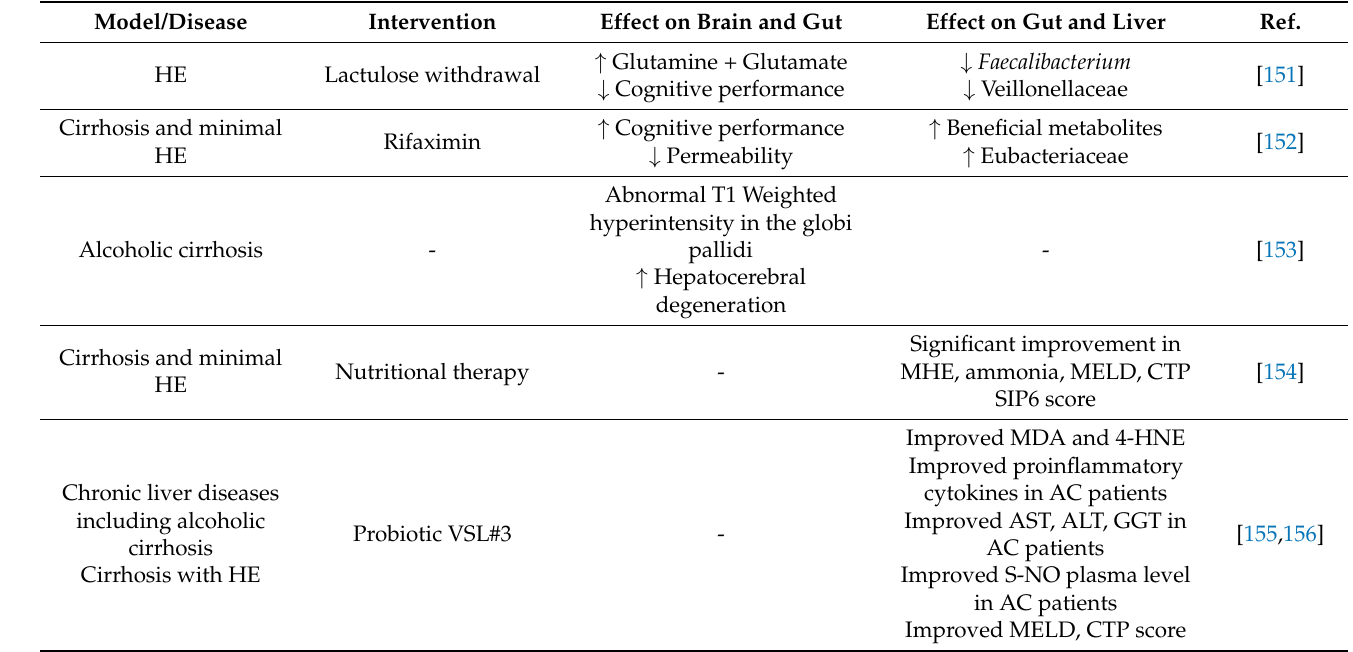
Table 2. Summary of effects of gut microbe and its metabolites implicated in brain and liver in alcohol-related clinical study.